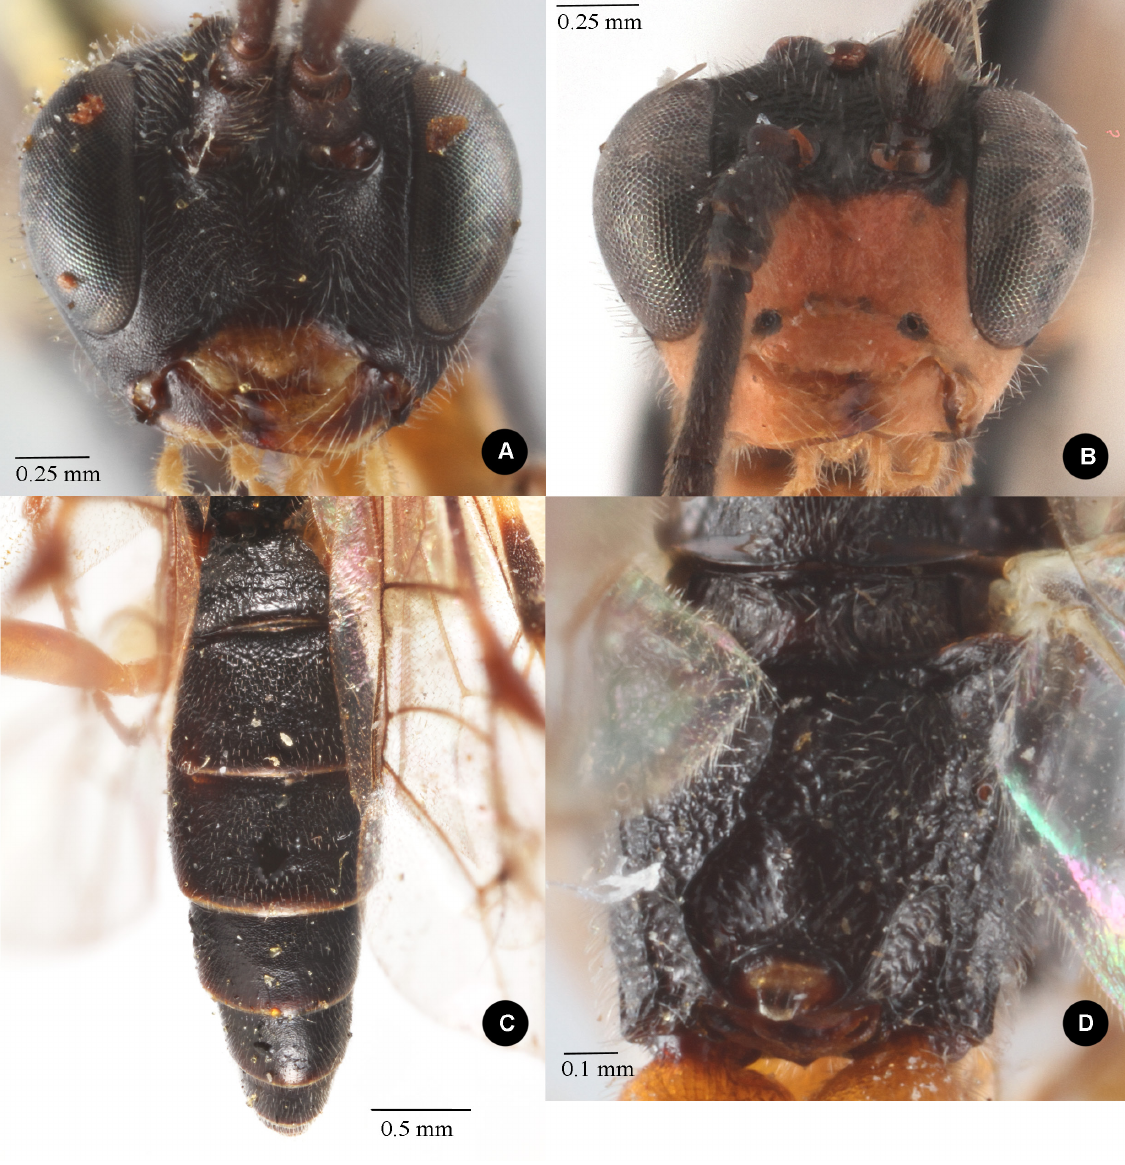
Fig. 15. Rhinotorus umbrarum (Holmgren, 1857). A . ♀, face. B . ♂, face. C . Metasoma dorsally. D .